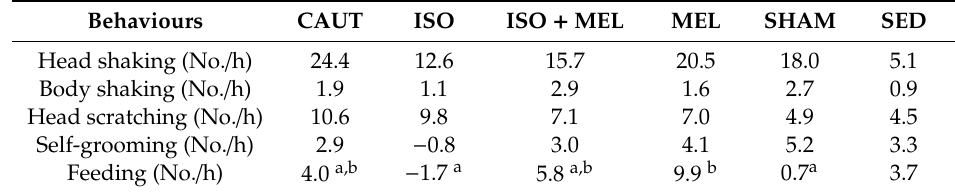
Table 3. Mean frequency (no. / h) of head shaking, body shaking, head scratching, self − grooming and feeding over 1 h post − treatment ( ± standard error of the di ff erence). Goat kids (n = 10 / treatment) were either (i) cautery-disbudded with no pain relief (CAUT), or disbudded following administration